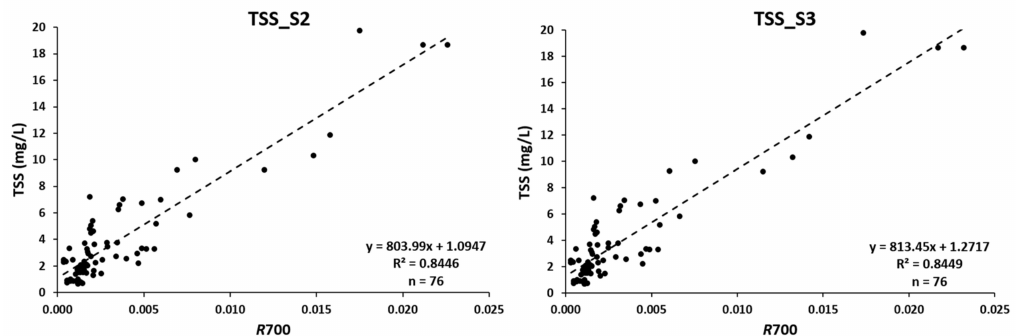
Figure 6. TSS algorithms recalculated using all data under 20